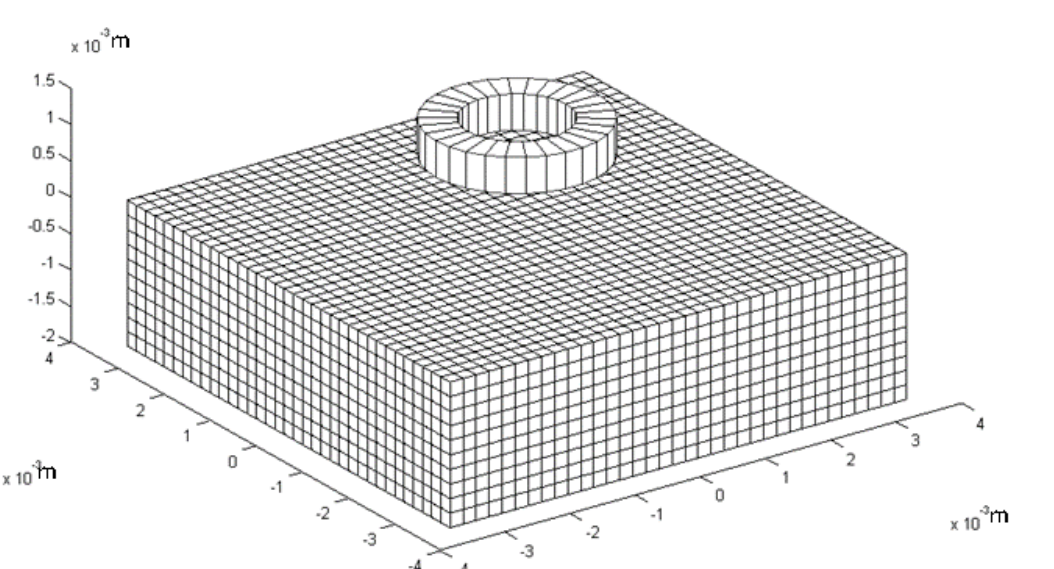
Figure 3. The benchmark case study: a pancake coil over a conducting plate. Table 2. Benchmark case: speed-up values for tasks (a) and (b) with OpenMP–MPI on SUNCUDA Cluster. Speed-Up MPI OpenMP Threads Tasks